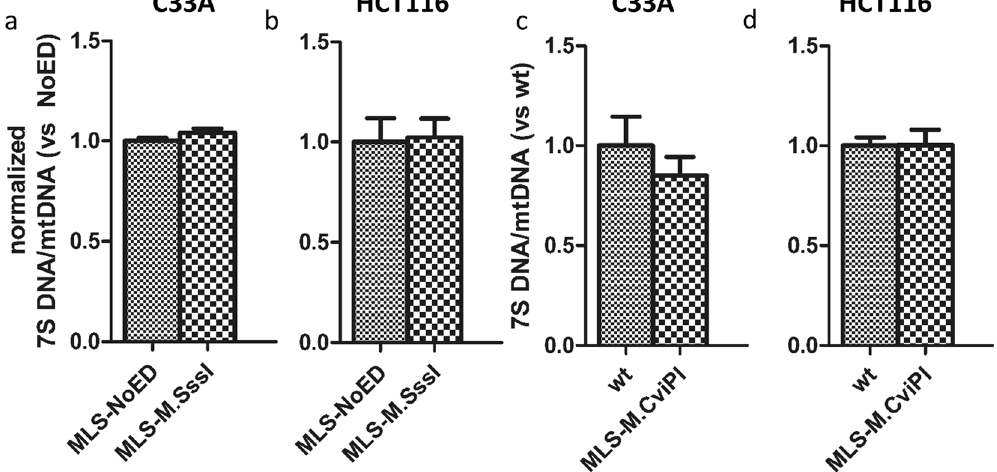
Figure 8. 7S DNA quantification in mitochondria-targeted M.SssI or M.CviPI. The effect of mitochondria- targeted M.SssI (MLS-M.SssI) on 7S DNA primer formation normalised to empty vector control (MLS-NoED) was determined in stable cell lines of C33A ( a ) or HCT116 ( b ). Similarly, the effect of mitochondria-targeted M.CviPI (MLS-M.CvPI) on 7S DNA primer formation normalised to wild-type control (wt) was determined in stable cell lines of C33A ( c ) or HCT116 ( d ). Each data point represents the mean ± SEM of three independent